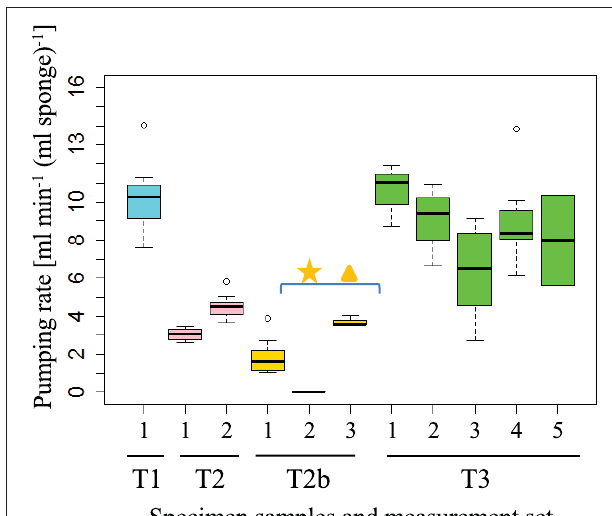
FIGURE 2 | Pumping rates of an individual sponge (osculum, T1–T3) measured by the DFS method at different times (black squares in Figures S6–S9). The measured flow rate is normalized to the volume of the sponge “pumping unit” drained by the measured osculum. Each set of measurements consisted of 5 ± 3 DFS experiments over 21 ± 20 min. The first osculum in which DO was measured in T2b was not pumping (star), the water flow speed was therefore measured in a second osculum (triangle). Individual Dye Front speeds for each sponge are presented in Figures S3–S5,